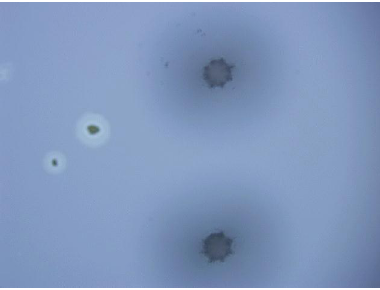
Figure 9. Picture of the bonding area of via holes and silicon.